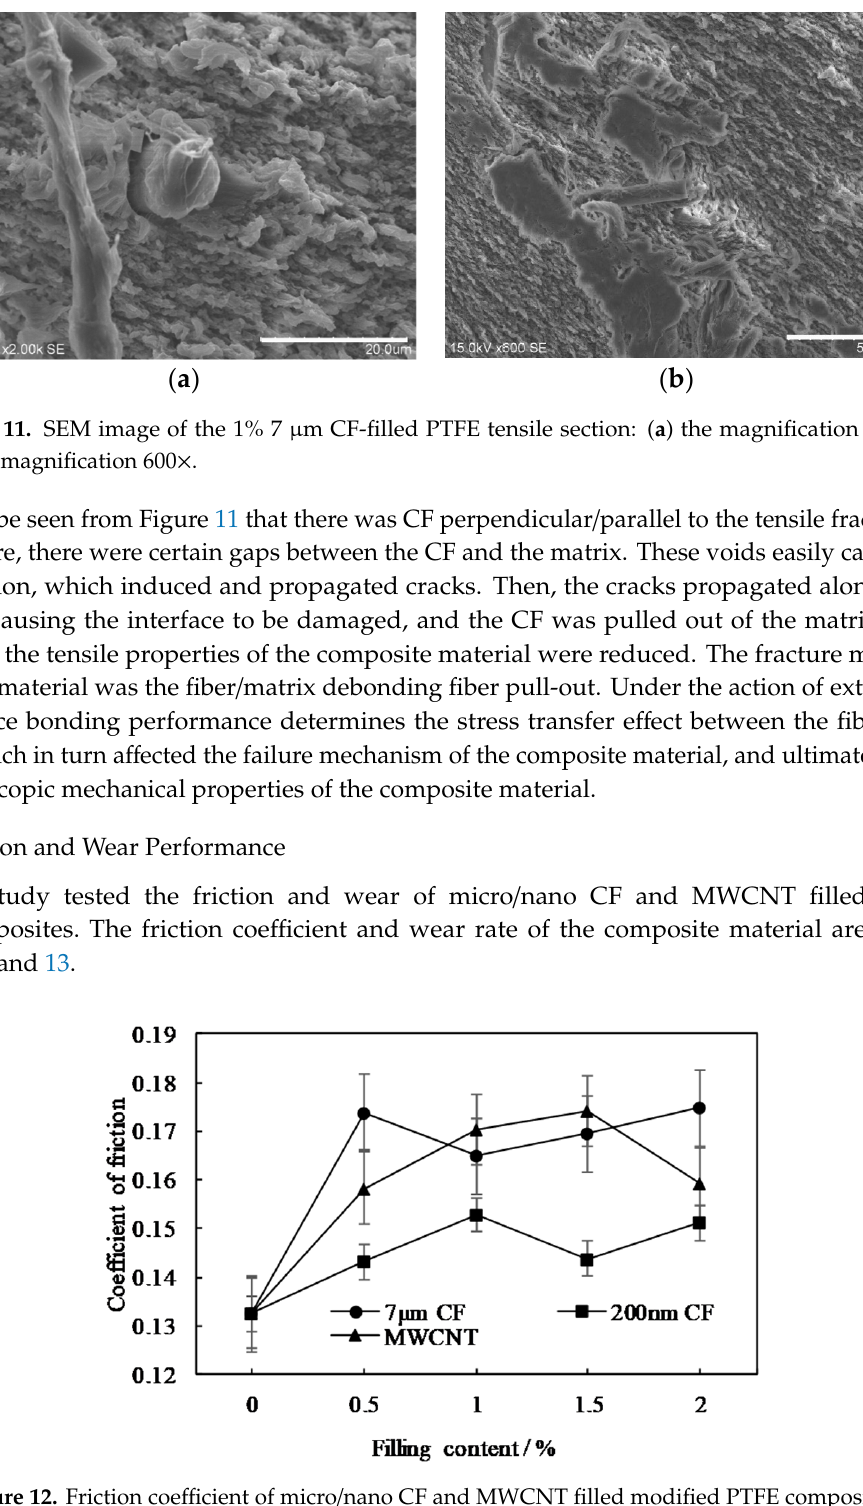
Figure 13. Wear rate of micro/nano CF and MWCNT filled modified PTFE composites. It can be seen from Figure 12 that the addition of different carbon materials slightly increased the friction coefficient of the composite material. It can be seen from Figure 13 that the strength and load-bearing capacity of the composite material were improved, indicating that the ability of the composite material to resist plastic deformation was significantly improved, and the ploughing effect of the grinding parts on the surface of the composite material was reduced. The addition of CF and MWCNT has greatly improved the wear resistance of composite materials. Under the experimental conditions, as the content of different types of carbon materials increased, the wear of composite materials decreased significantly. Among them, when 7 μm CF was used as the modified filler and the mass fraction was 1.5%, the wear rate of the composite material dropped from 7.8463 × 10 −4 to 2.5124 × 10 −4 mm 3 /Nm, a decrease of 58%. Subsequently, the wear rate of the composite material increased slightly. When 200 nm CF was used as a modified filler and the mass fraction was 1%, the wear rate of the composite material decreased from 7.8463 × 10 −4 to 3.9038 × 10 −4 mm 3 /Nm, a decrease of 50.3%. Then the wear rate gradually increased. When MWCNT was used as a modified filling and the mass fraction was only 0.5%, the wear rate of the composite material decreased from 7.8463 × 10 −4 to 2.5897 × 10 −4 mm 3 /Nm, a decrease of 57%. Subsequently, the wear rate increased slowly, but the wear rate remained below 50% of the unmodified PTFE.